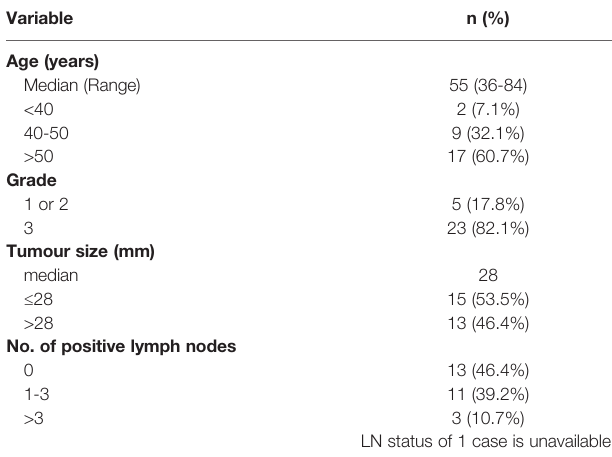
TABLE 1 | Clinical characteristics of 28 TNBC samples of the fi rst